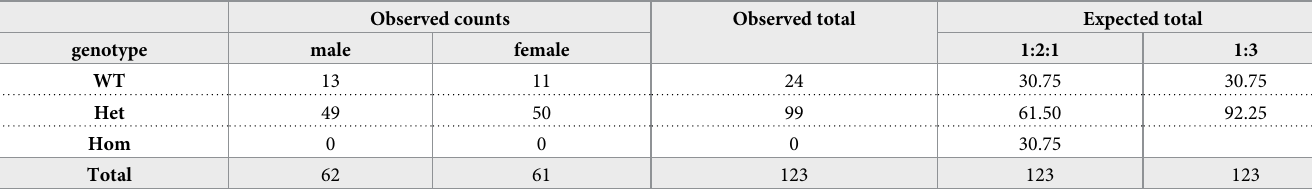
Pups were genotyped by conventional PCR. Both methods described in Fig 2 produced identical results. All breeders were known to be heterozygous because one of their parents was a wild type. No homozygote pup was identified and there was no difference between male and female counts. Observed pup genotype counts